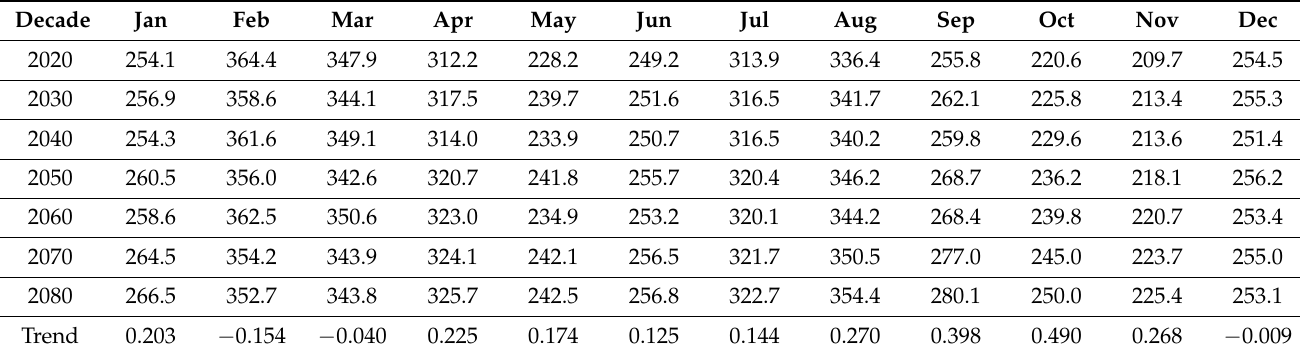
Table 3. Monthly mean precipitation values per decade and their trend for Popayan, Colombia, obtained from the application of the delta method to the coupled models (CMIP5) and for the average of the four routes of the Representative Concentration Pathways (RCP) found in the 2014 IPCC report.